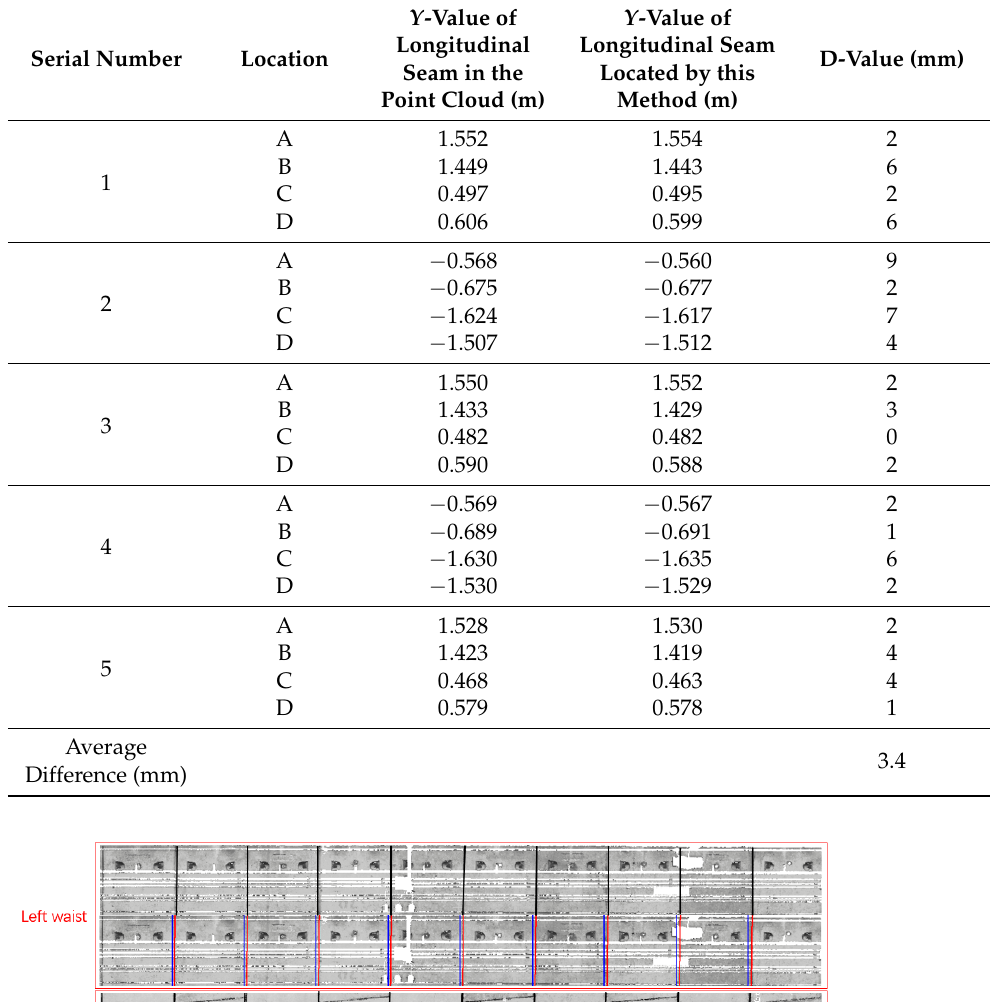
Table 3. Comparison between the original cloud seams and proposed method.